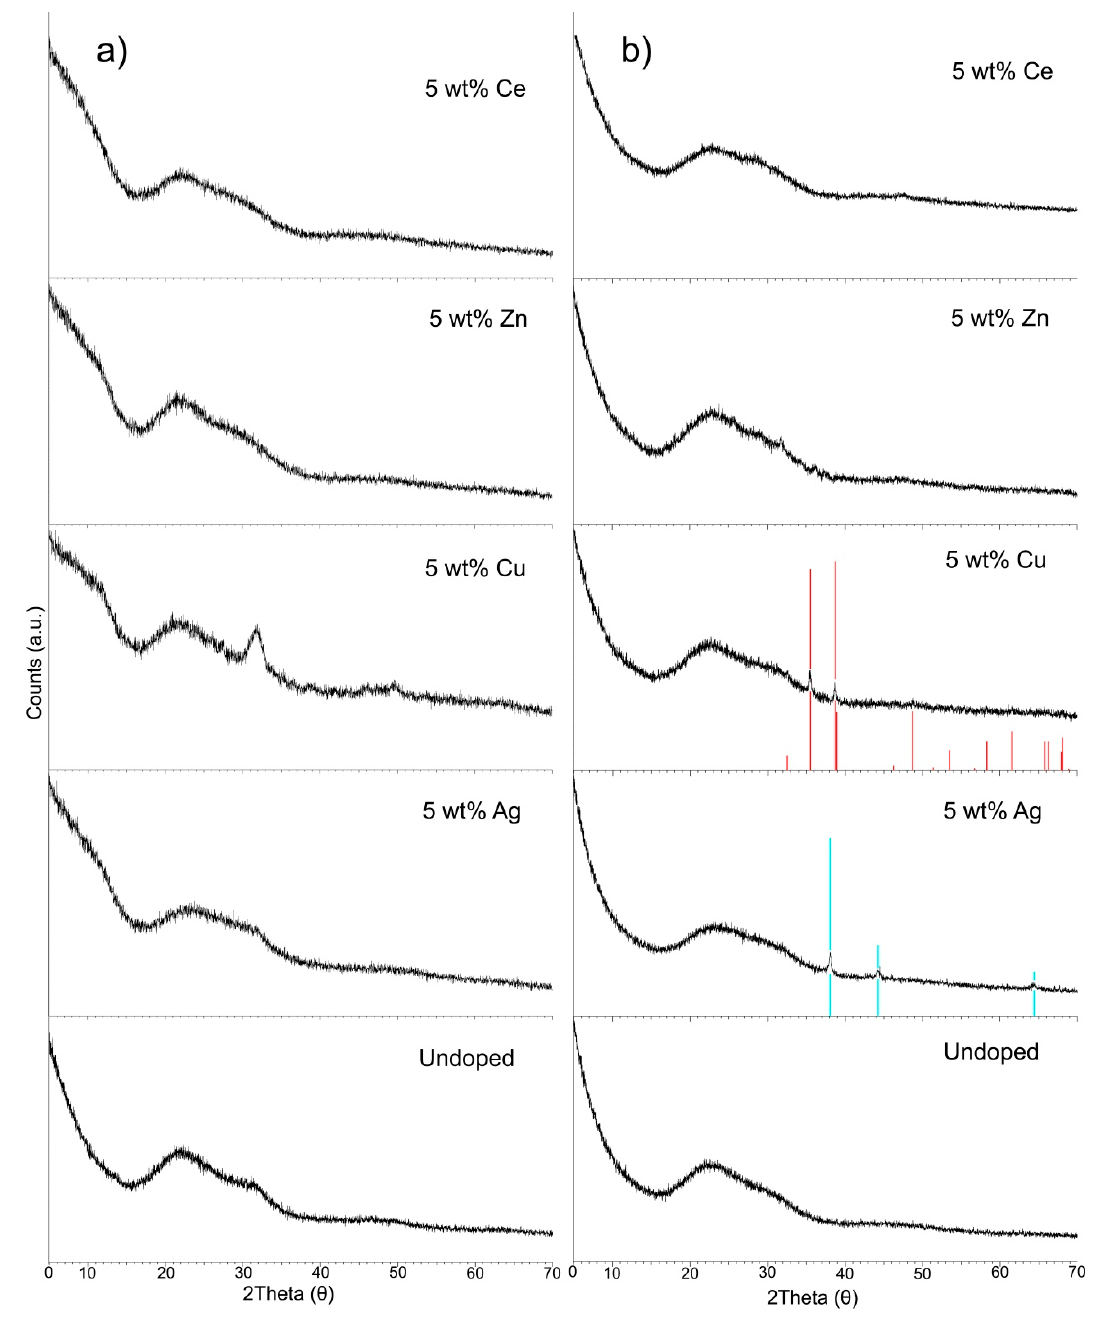
Figure 6. X-ray diffraction (XRD) spectra of: ( a ) Undoped and doped non-ordered mesoporous glasses; ( b ) undoped and doped ordered mesoporous glasses.